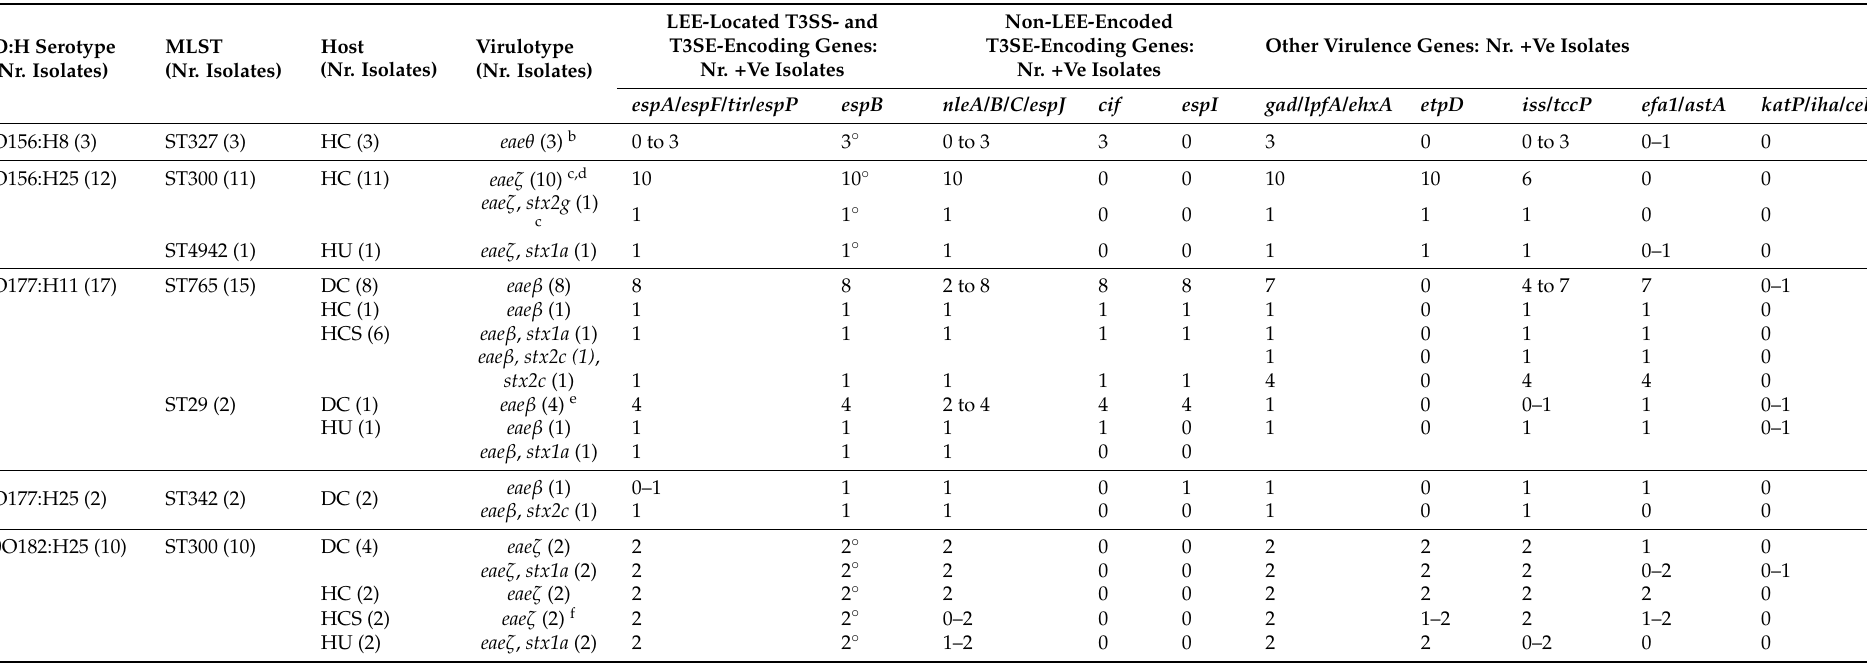
Table 2. Comparison of the type 3 secretion system (T3SS)-, type 3-secreted effector (T3SE)-encoding genes and other virulence-associated-encoding genes identified by WGS in the bovine EPEC and bovine and human AE-STEC belonging to the O156, O177, and O182 O